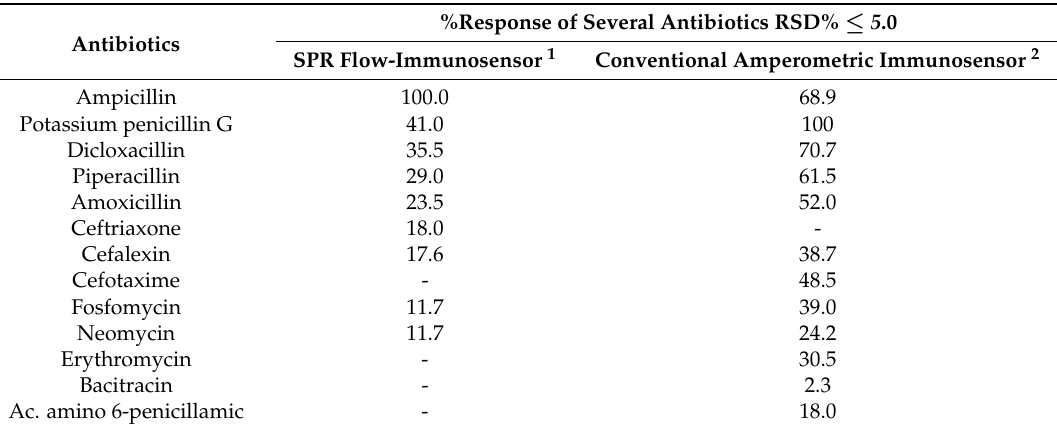
Table 3. Percent cross selectivity values for several common antibiotics.